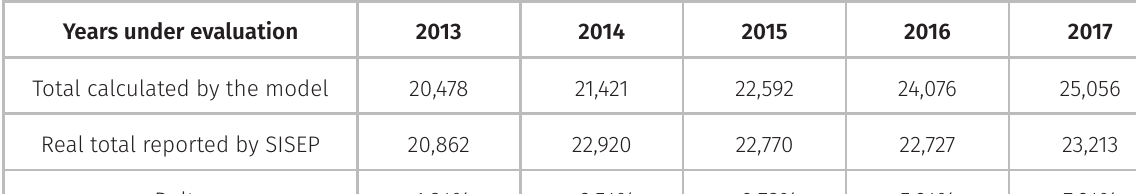
Figure 4. Projection of the evaluation of the model in kg/person-day for the range in Minimum